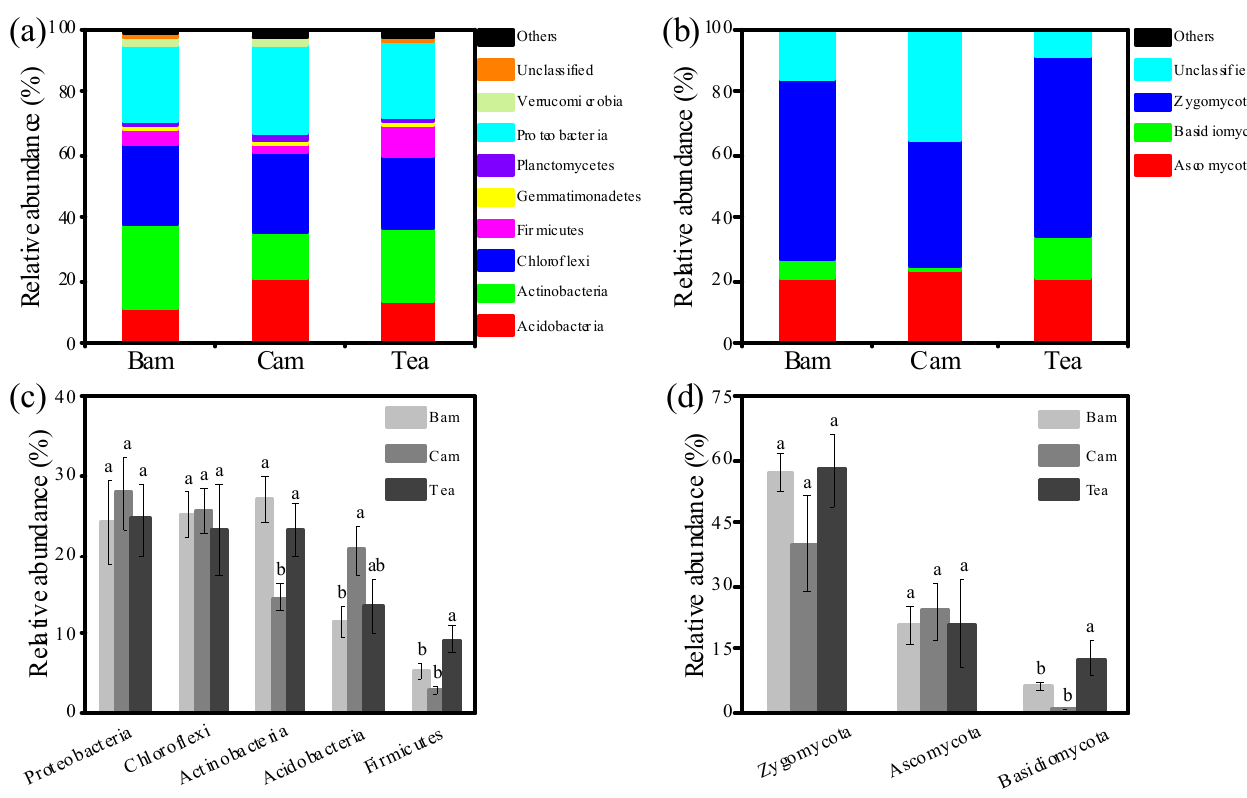
Figure 4. Relative abundances of soil bacterial ( a ) and fungal ( b ) phyla, and the dominant bacterial ( c ) and fungal ( d ) phyla in bamboo (Bam), camphor (Cam), and tea (Tea) plantations. The same letters were not statistically different at p < 0.05. Table 4. Soil bacterial and fungal diversities and enzyme activities in bamboo (Bam), camphor (Cam), and tea (Tea) plantations.